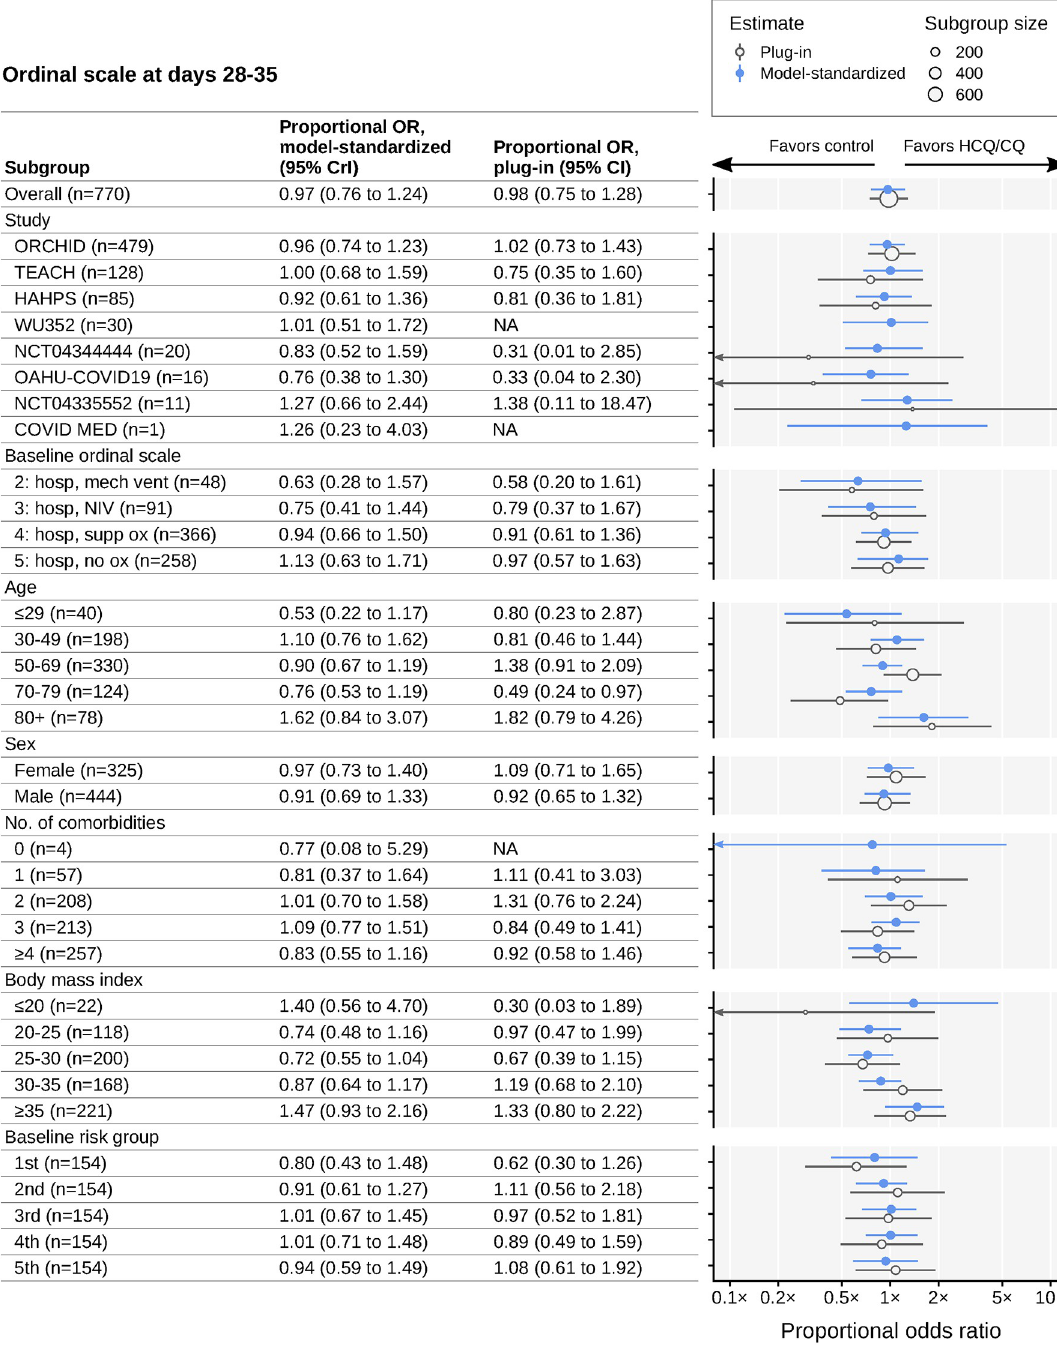
Fig 3. Subgroup analysis of differences in ordinal scale at days 28–35. Estimated proportional odds ratios comparing day 28–35 ordinal scale in HCQ/CQ versus control groups. Estimates are given for the pooled patient population and for subgroups. Blue circles represent model-standardized estimates; blue horizontal lines represent 95% credible intervals. Open grey circles represent plug-in estimates; grey horizontal lines represent 95% confidence intervals. Grey circle size represents the number of patients in the corresponding subgroup. Arrows indicate uncertainty intervals extending beyond plot limits. Study acronyms are explained in Fig 1. Two trials did not have study acronyms (only trial registration numbers). Abbreviations: 95% CrI, 95% credible intervals; HCQ/CQ, hydroxychloroquine or chloroquine; NA, not applicable; NIV, noninvasive ventilation (includes BiPAP/CPAP and/or high-flow oxygen); OR, odds ratio.